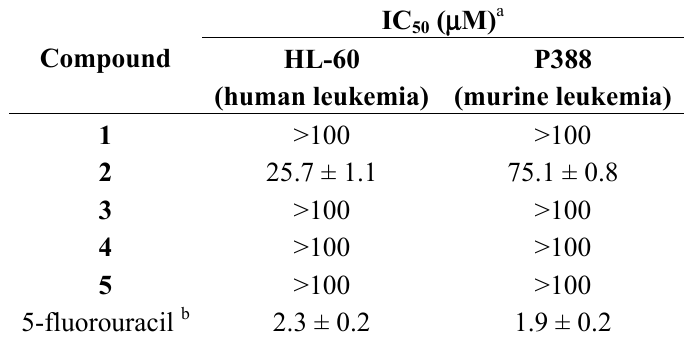
Table 2. Cytotoxic activity of multiflorane-type triterpenes from Cucurbita pepo